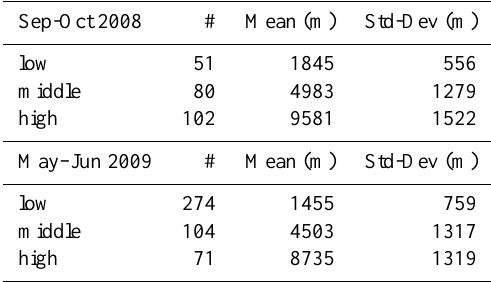
Table 2. Cloud altitudes detected over Palaiseau site during the RISC-UV campaigns. #: number of observations when cloud al- titudes could be defined. Mean and Std-Dev: mean and standard deviations of the cloud altitudes classified in three categories: low ( < 3km), middle (3–7km) and high level clouds ( >